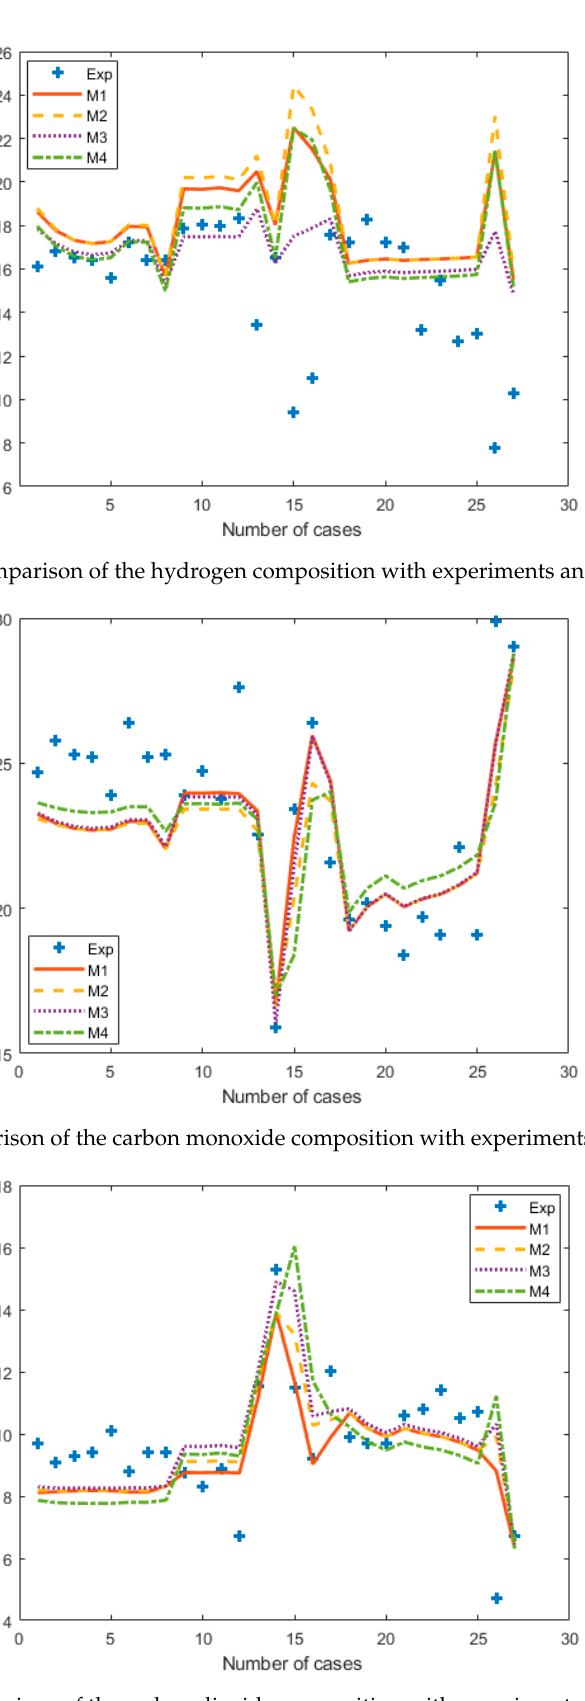
Figure 6. Comparison of the methane composition with experiments and models. Figure 7. Comparison of the nitrogen composition with experiments and models.